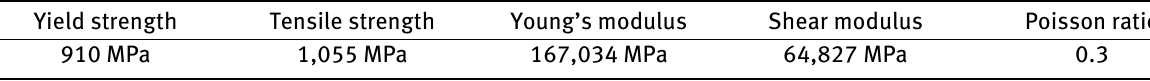
Table 1: Mechanical properties of Inconel 738 at 600 ∘ C Yield strength